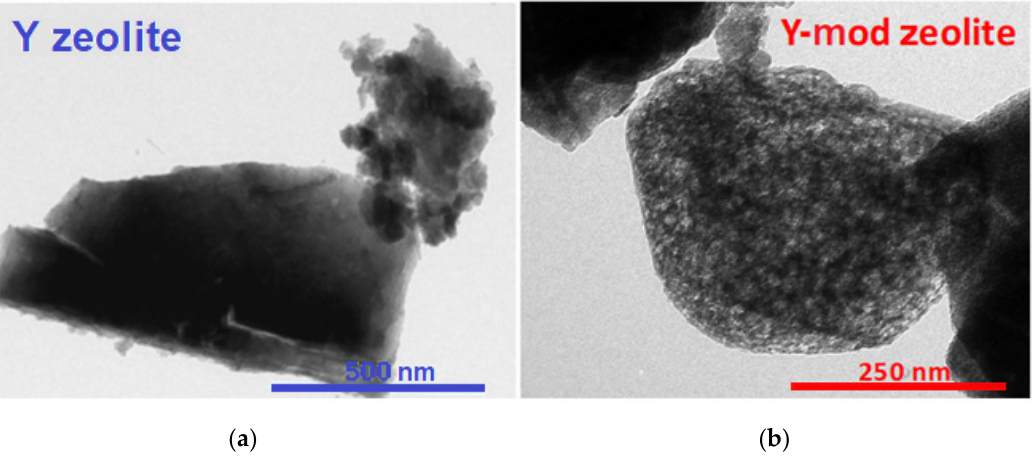
Figure 3. TEM microphotographs of Y zeolite ( a ) and Y ‐ mod zeolite ( b ).